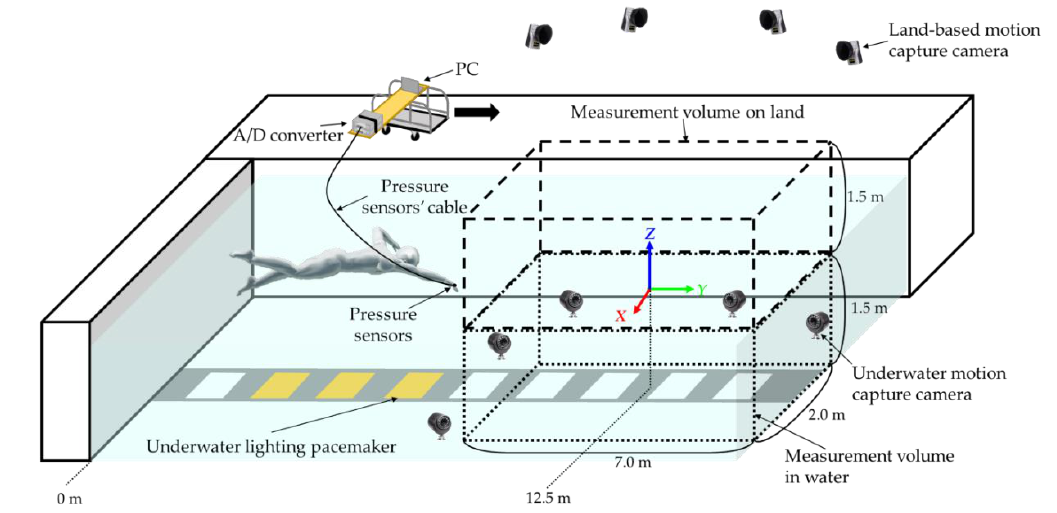
Figure 5. Schematic diagram showing experimental environment. To measure the pressure around the hands, six wired pressure sensors were attached to the palm and dorsal sides of both hands using double-sided tape in the same positions, as shown in Figure 2. The pressure was recorded at a sampling rate of 200 Hz. The signal output from the pressure sensors was recorded on a PC using an A/D converter (EDX-100A, Kyowa Electronic Instruments Co. Ltd., Tokyo, Japan). The PC and A/D converters were mounted on a push cart such that they propagated along with the swimmers. similar to the procedure in [18]. Four 19 mm reflective markers were attached to the second and fifth metacarpophalangeal joints (hereinafter denoted as second MCP and fifth MCP, respectively), radial styloid (RST), and ulnar styloid (UST) using strong magnets and elastic medical cotton tape (Figure 6). Reflective tape was wrapped around the tip of the third finger, which was defined as the third TIP marker. Fourteen underwater cameras (Oqus3+ underwater, Qualisys, Göteborg, Sweden) and ten land-based cameras (Oqus3+, Qualisys, Göteborg, Sweden) were used for the experiment. The three-dimensional coordinates of the markers were recorded using motion-capture software (Qualisys Track Manager 2.15, Qualisys, Göteborg, Sweden) at a sampling rate of 200 Hz. The origin of the underwater motion-capture system was set at the water surface and 12.5 m away from the start. The transverse direction of the global frame was defined as the X -axis (right direction positive), the swimming direction as the Y -axis (forward positive), and vertical direction as the Z -axis (upward positive). The measurement volume was 2.0 m ( X -axis) × 7.0 m ( Y -axis) × 3.0 m ( Z -axis), i.e., 1.5 m underwater and 1.5 m above the water surface. The measurement volume was set 9.0 m away from the pool wall. The accuracy within the analysis range after calibration was obtained using a 600.1 mm rod, and the errors on land and in water were confirmed to be 2.3 and 1.9 mm, respectively.